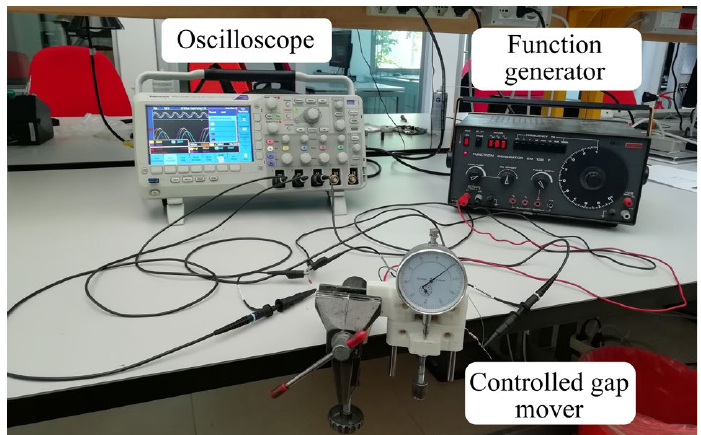
Figure 9. Experimental apparatus. Table 2. Nominal value properties of the components used during the experimental campaign.